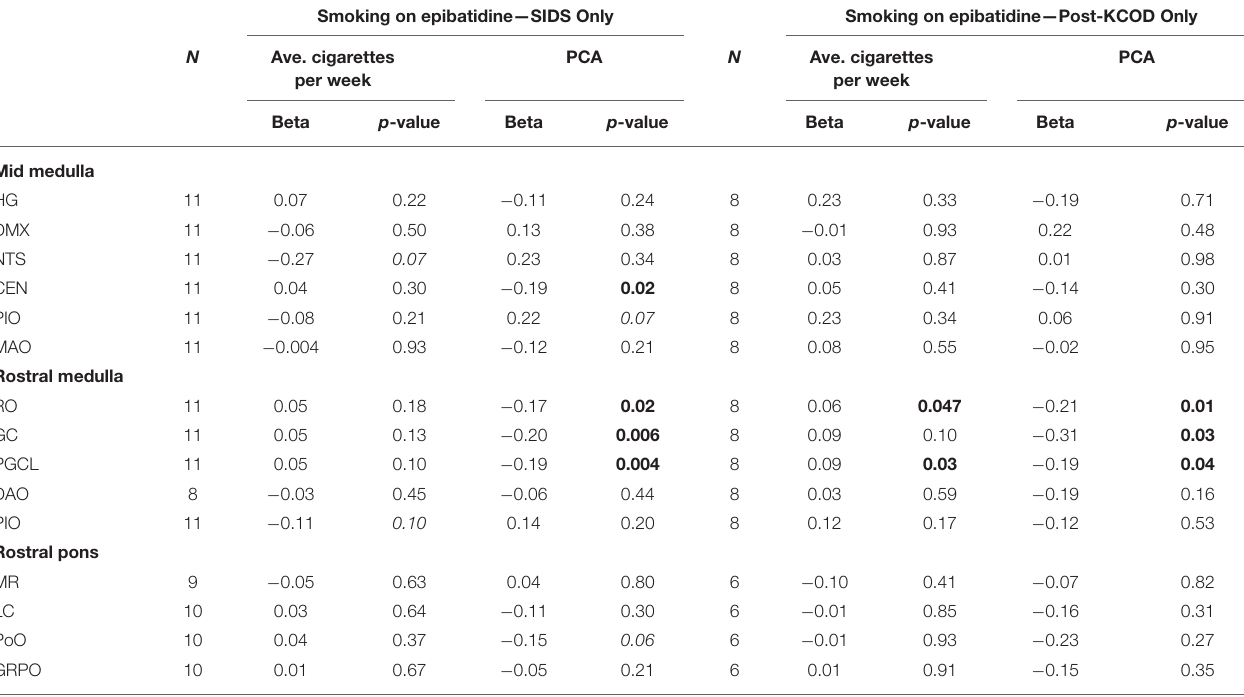
TABLE 7 | Effects of maternal cigarette smoking on 125 I-epibatidine binding in the brainstem in SIDS and Post-KCOD. Smoking on epibatidine—SIDS